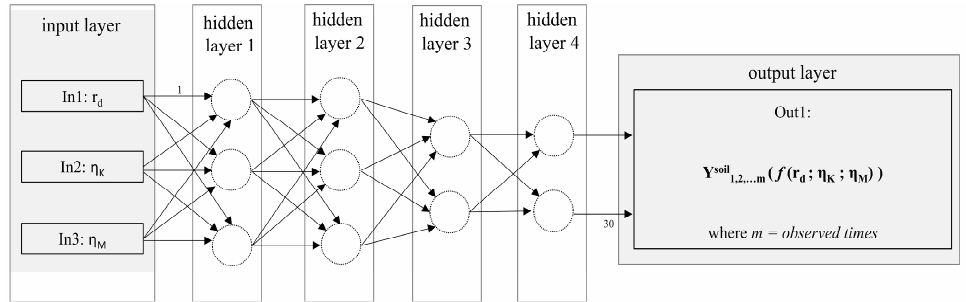
Figure 4. A scheme of a NetCREEP neural network.